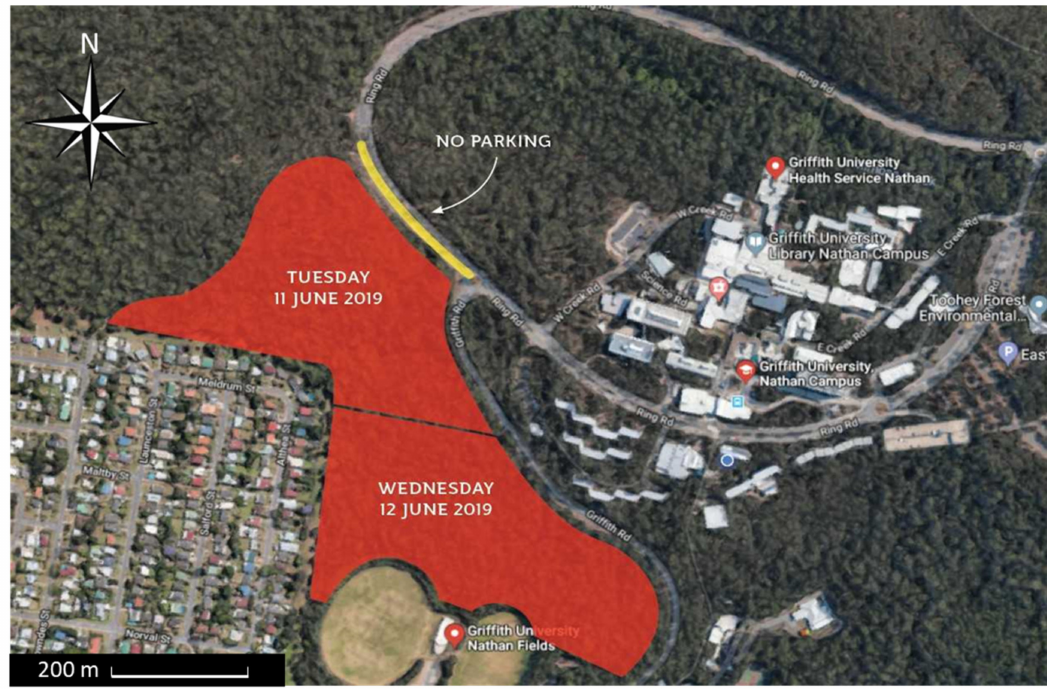
Figure 2. Map of hazard reduction burns carried out at Nathan campus of Gri ffi th University on 11 and 12 June